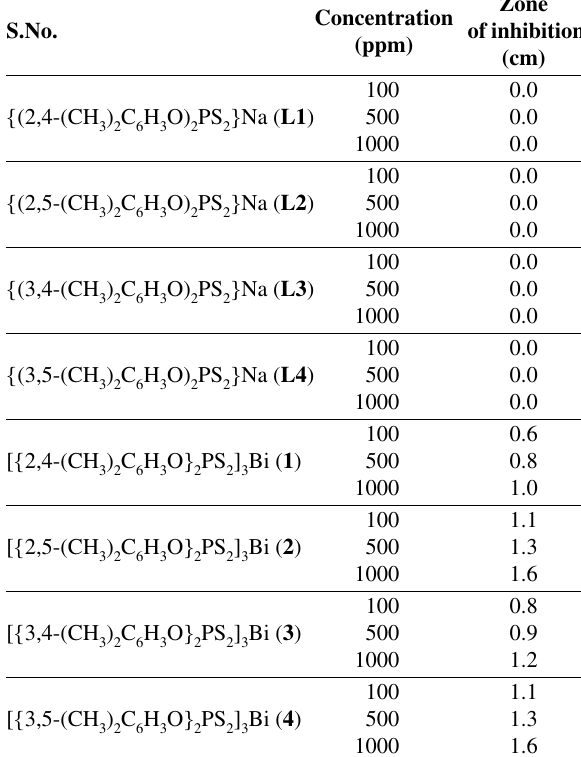
Table 3. Antifungal activity of diphenyl dithiophosphate ligands and bismuth(III) complexes against the fungus Penicillium chryso- genum . Concentration